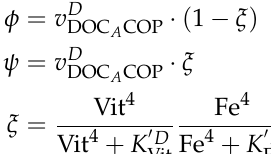
= 0.1, K (cid:48) D = 0.5. Vit Fe